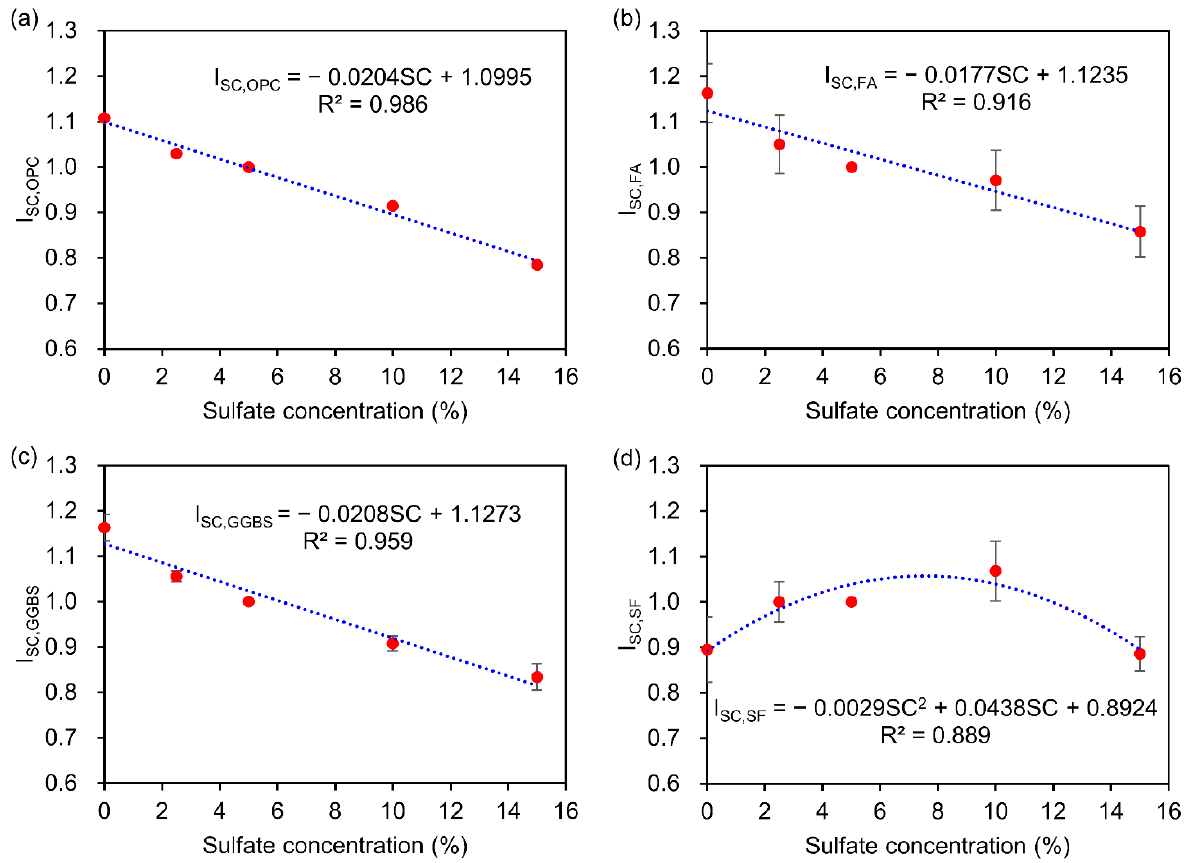
Figure 4. Effect of sulfate concentration on DRC of concrete containing different mineral admixtures exposed to DW cycles with SA: ( a ) OPC concrete; ( b ) FA concrete; ( c ) GGBS concrete; ( d ) SF concrete.